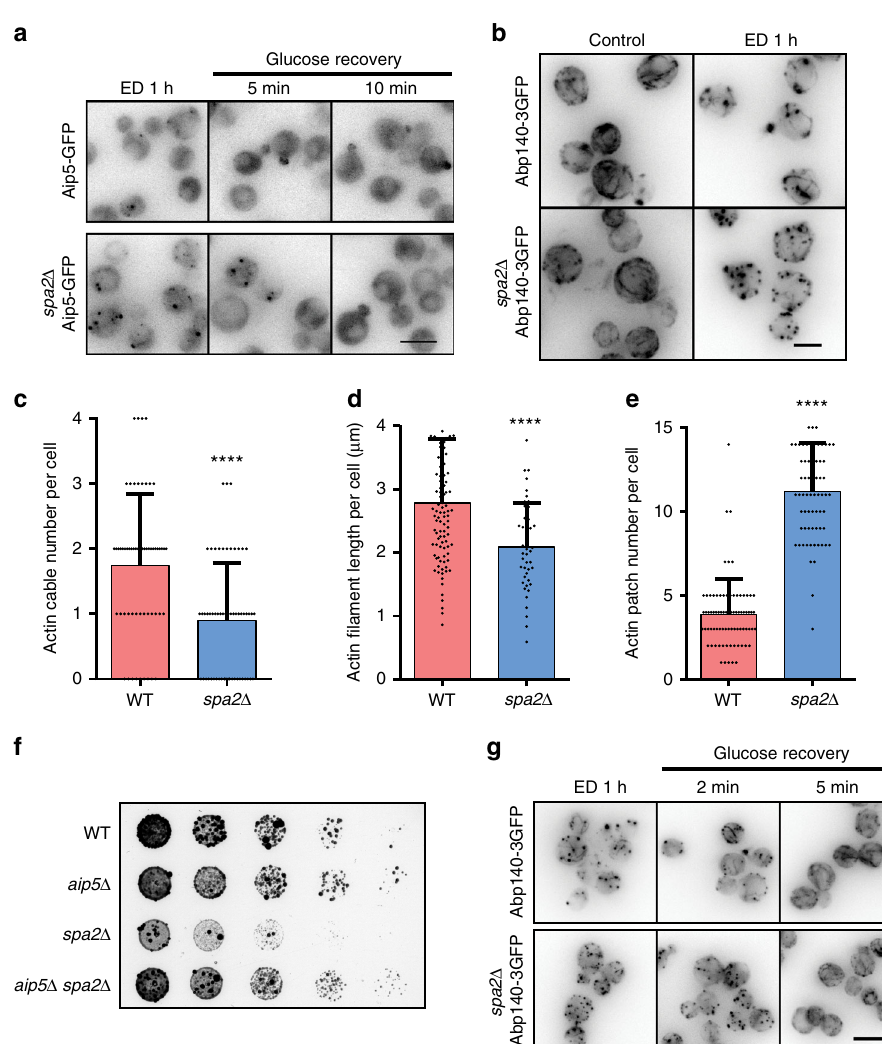
Fig. 6 Reversible in vivo condensation of Aip5 under stress condition. a Representative maximum Z -projection images of in vivo formed Aip5-GFP condensates under 1 h of energy-depletion treatment and followed by replenishment of 2% glucose. The scale bar represents 5 µ m. b Representative maximum Z -projection fl uorescence images of Abp140-3GFP revealed actin cable pattern in WT and spa2 Δ , with or without 1 h of energy depletion. Scale bar represents 3 µ m. c – e Quanti fi cation of the Abp140-3GFP marked actin cables and actin patches that were imaged in b under energy-depletion treatment for 1 h (cells for analyzing actin cable number: n = 59 for WT and spa2 Δ ; Actin cable length: n = 99 for WT and n = 45 for spa2 Δ ; cells for analyzing actin patch number: n = 87 for WT and n = 70 for spa2 Δ ). f Yeast growth assay on YPD plate with 3.1 mM 2-deoxy- D -glucose and 0.31 µ M antimycin A for 72 h at 30 °C. g Representative maximum Z -projection images of Abp140-3xGFP-labeled actin cables from the indicated strains after 1 h